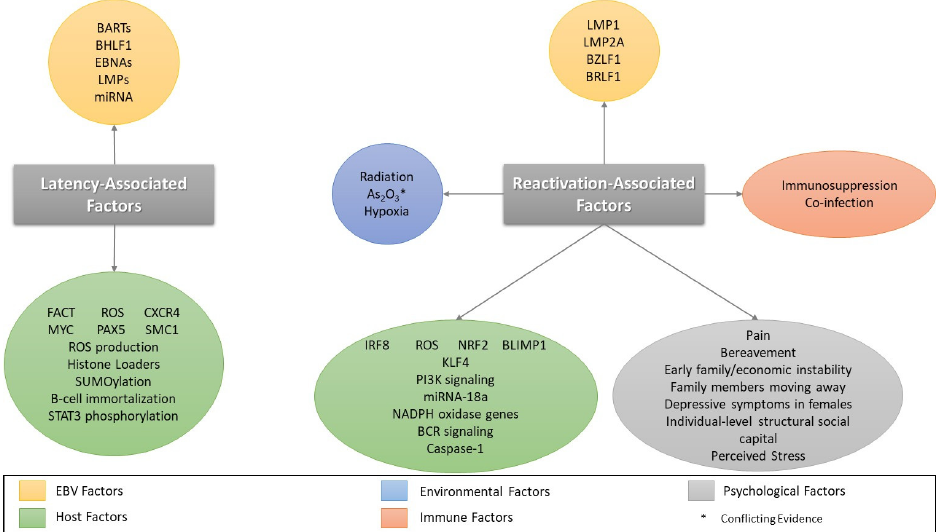
Figure 3. Summary of Factors Involved in Latency and Reactivation. Factors associated with la- tency and reactivation are categorized by